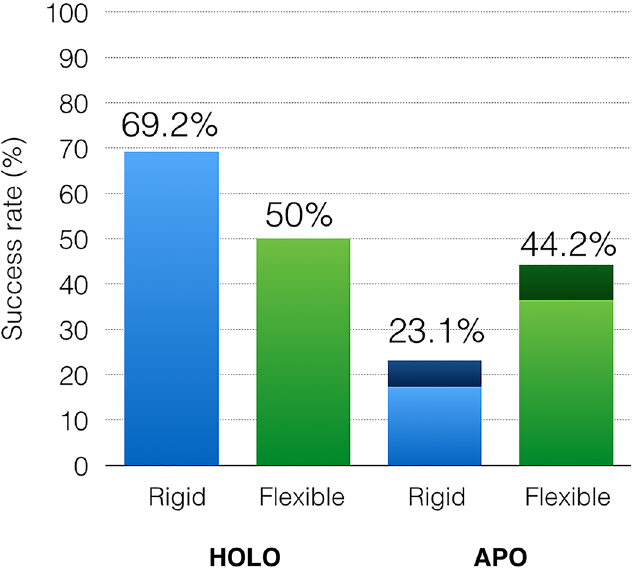
Fig 11. Impact of making 12 receptor side-chains flexible when docking ligands into the native holo receptor and the apo receptor. An expected loss of accuracy is observed when making the native holo receptor flexible, reflecting shortcomings in the scoring function and search method. Adding flexibility to the apo receptor, however, improves the docking success rate. Holo docking success rates are shown for ligand RMSD < 2 Å . The success rate for apo cross-docking increases from 17.3% to 36.5% with a 2.0 Å RMSD cutoff. This success rate increases from 23.1% to 44.2% when using a 2.5 Å RMSD cutoff (darker shade